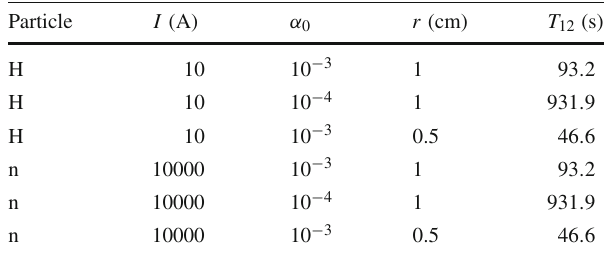
Table 4 Transition times from the first to the second gravitational state caused by the oscillation of the wire and estimated in accordance with Eq.